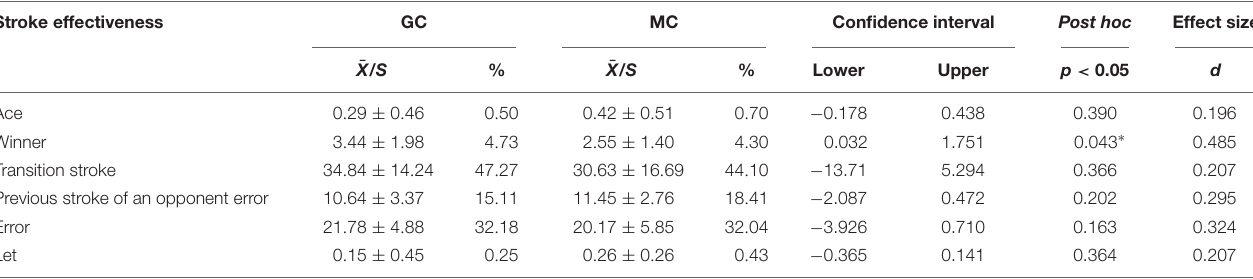
GC = Tennis 10s Green Competition, Modified Competition = MC. ¯ X = mean, S = standard deviation Post hoc: statistically significant differences = p < 0.05 ∗ . Effect size = Cohen’s